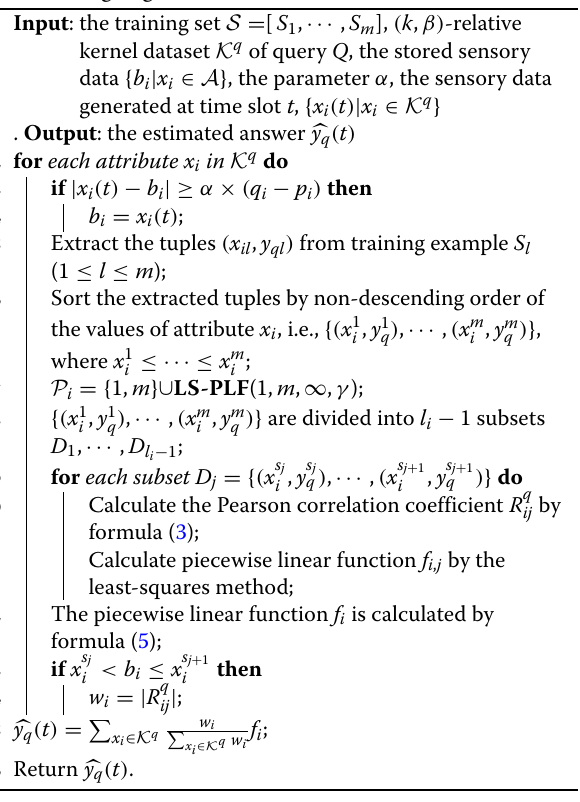
Algorithm 5: Temporal Correlation Based Answer Estimating